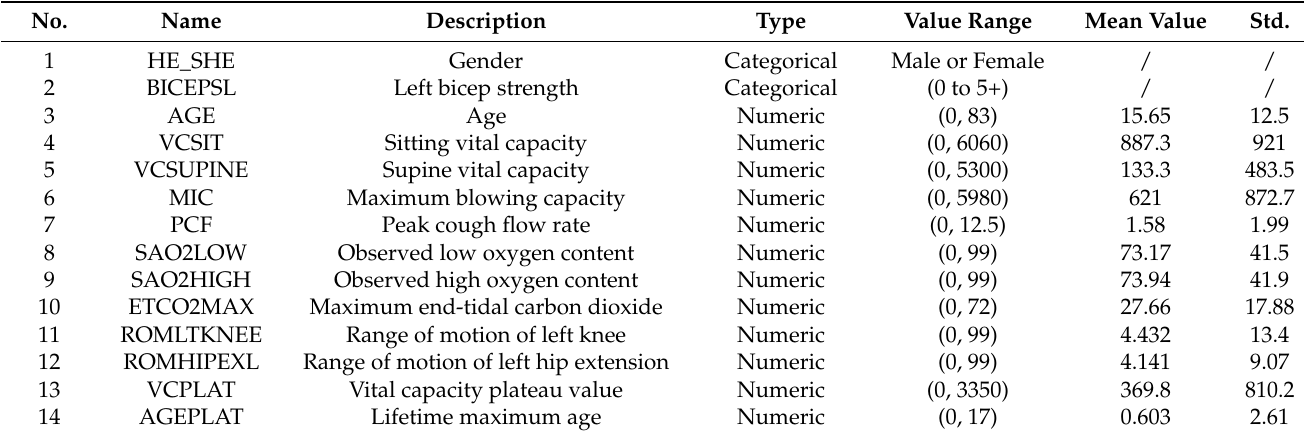
Table 1. Description of partial medical